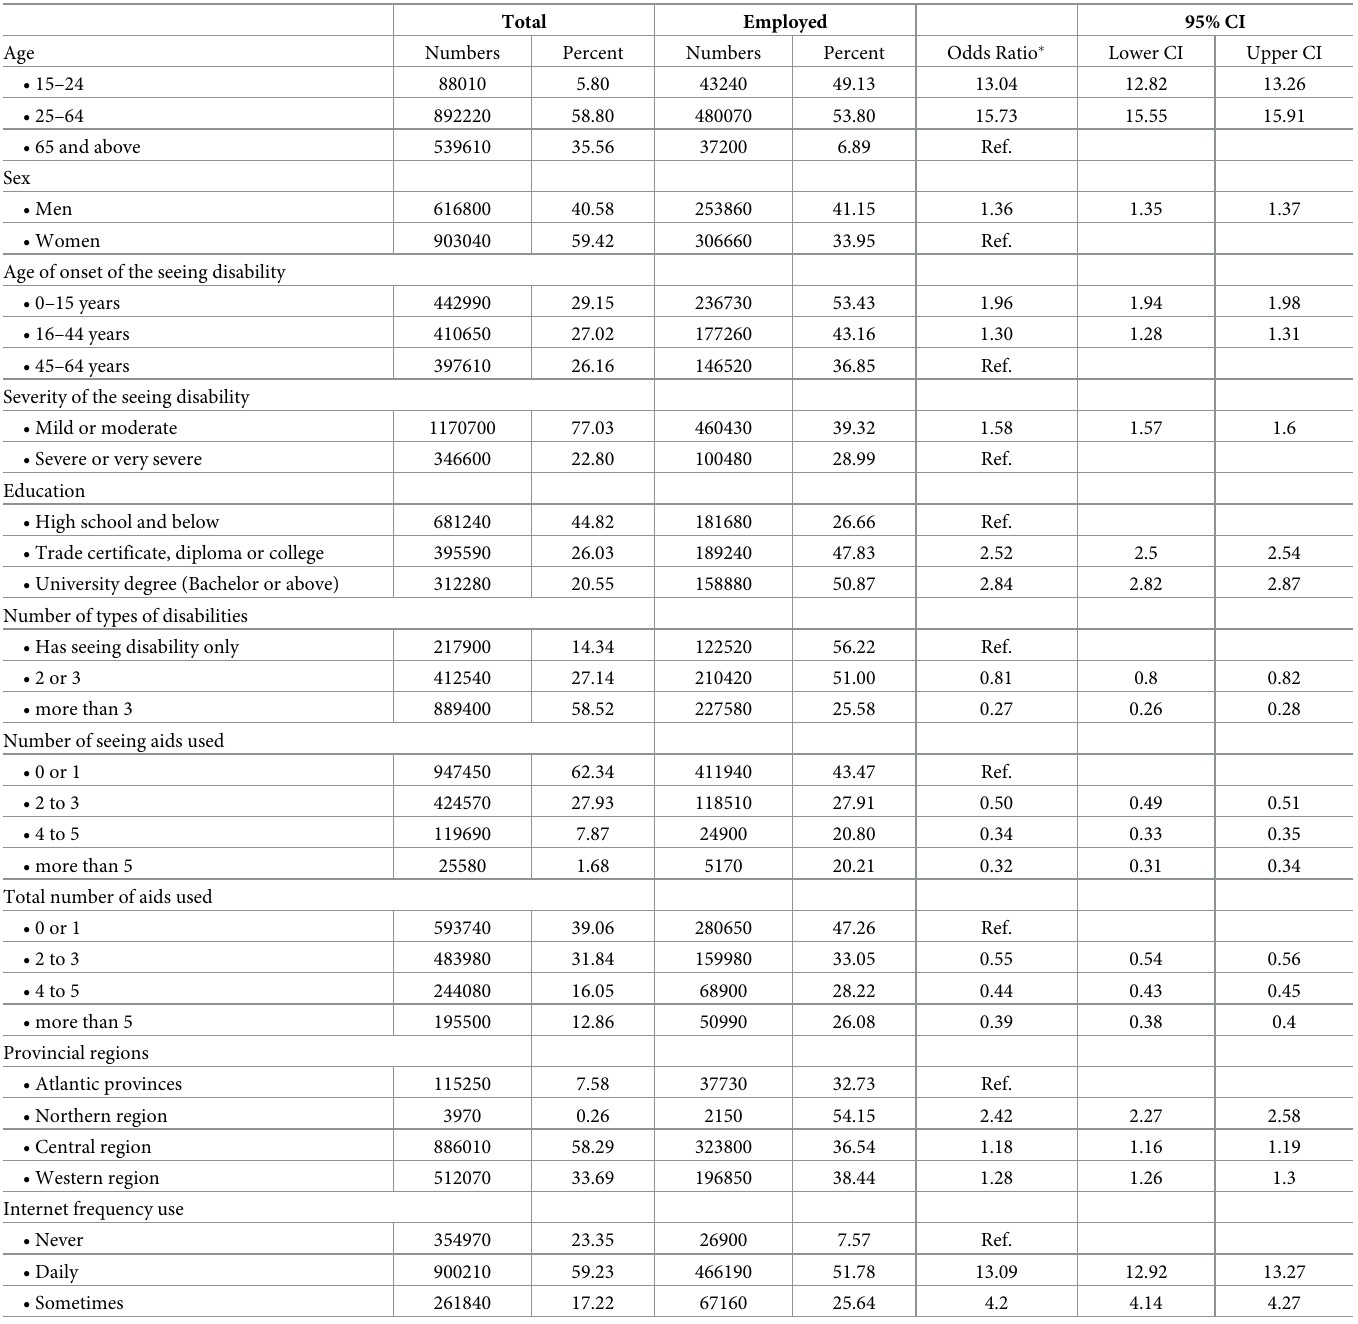
Table 2. Employment profile of persons with seeing disability in Canada, 2017 (N = 1,519,840). Total Employed 95% CI Age Numbers Percent Numbers Percent Odds Ratio � Lower CI Upper